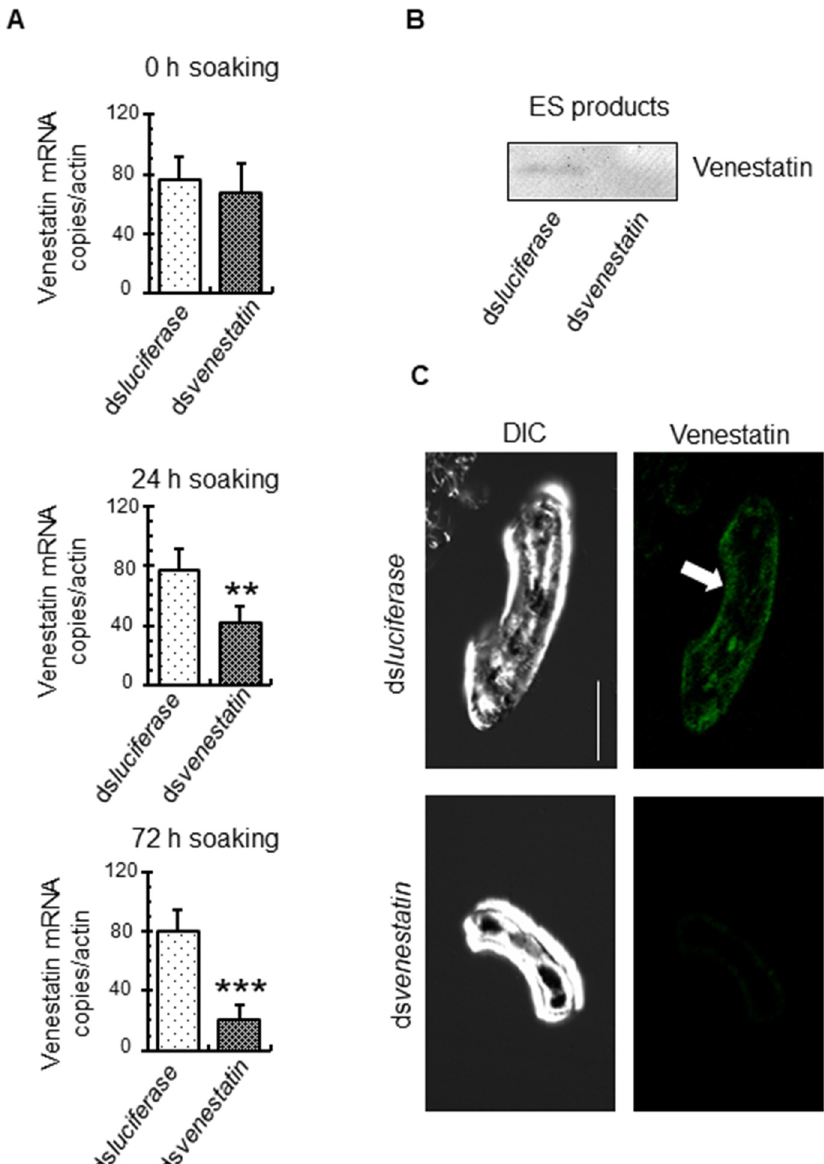
Fig 3. Post-transcriptional silencing of the venestatin gene in S . venezuelensis . (A) Quantitative RT-PCR analysis of venestatin transcripts. Lung stage larvae (LL3s) of S . venezuelensis were incubated with venestatin dsRNA as the RNAi- treated group. LL3s in the control group were incubated with luciferase dsRNA. The gene encoding S . venezuelensis actin-like protein (actin) was used as an internal control, and venestatin mRNA copies/actin was calculated. Data are expressed as means ± SDs for three independent experiments with two technical replicates. �� p < 0.001; ��� p < 0.0001 from the control group. (B) Effects of gene silencing on venestatin protein expression by western blot analysis. Excretory-secretory (ES) products (1 mL culture medium from 10,000 LL3s) were collected after 72 h of soaking with dsRNA and concentrated to 100 μ L by ultrafiltration. Proteins were separated by SDS-PAGE on 12% gels under reducing conditions. Membranes were probed with anti-venestatin sera. (C) In situ detection of venestatin expression in LL3s. Immunofluorescent staining of LL3s using mouse anti-venestatin sera was performed after 72 h of soaking with dsRNA. Bound antibodies were probed with green fluorescent-labeled secondary antibodies. The sections were examined by confocal fluorescent microscopy. Differential interference contrast (DIC) images are also shown. Intense expression of native venestatin (arrow) was observed in the hypodermis of LL3s in the control group, but not in the RNAi-treated group. Scale bar: 50 μ